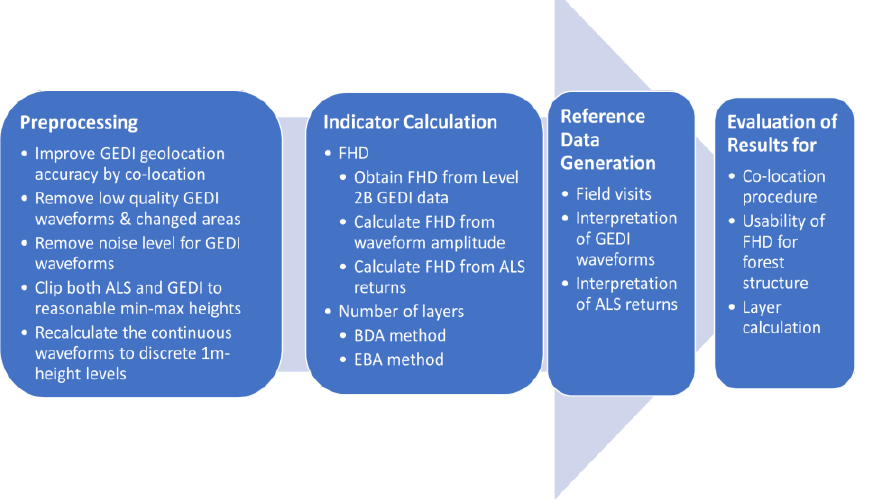
Figure 2. Overall workflow used in this study (abbreviations: BDA = break detection algorithm; EBA = expert-based assessment). EBA = expert-based